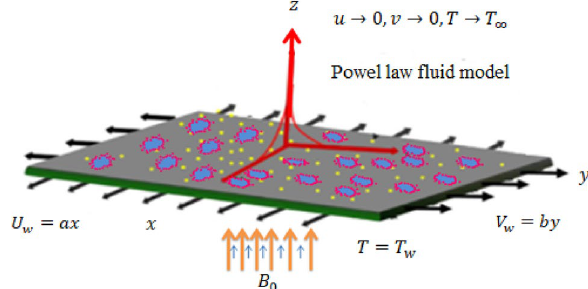
Figure 1. Physical model with coordinate